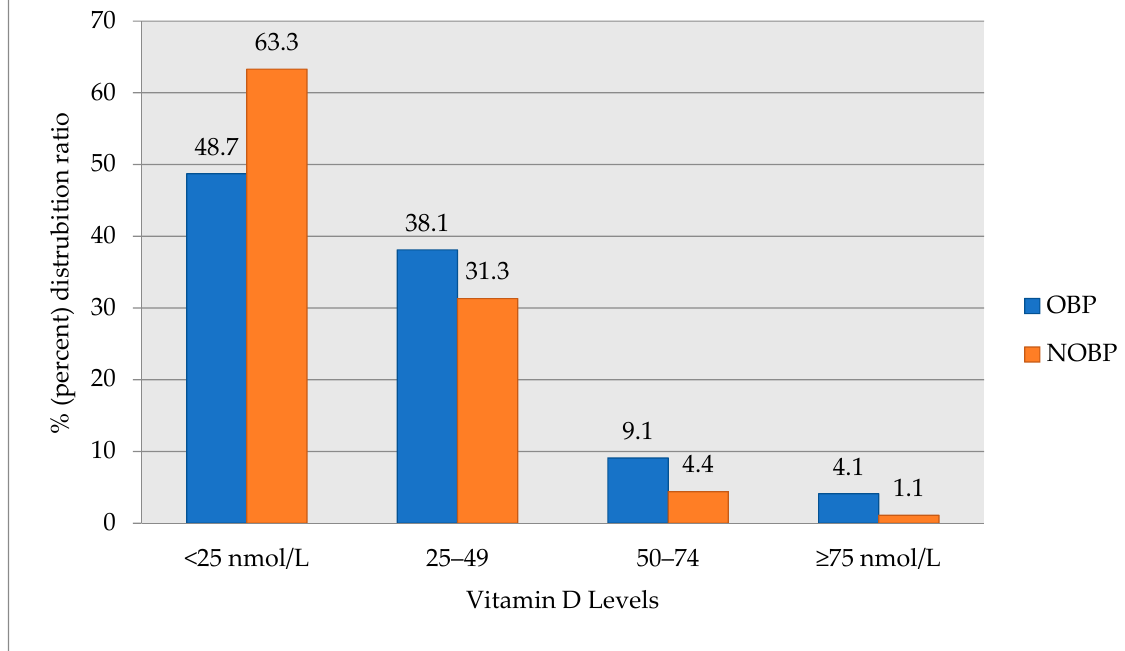
Figure 3. Comparison of vitamin D and PTH levels between groups (OBP and NOBP) by gender. OBP, optimal blood pressure; NOBP, non-optimal blood pressure; VitD, vitamin D; PTH, parathyroid hormone.